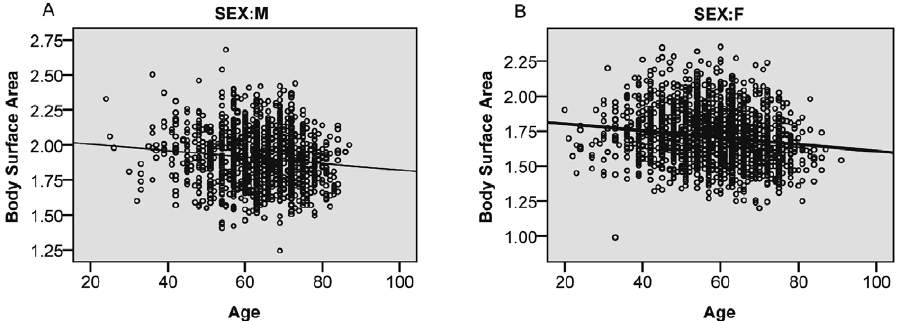
Figure 3. Correlation between age and BSA. The BSA was negatively correlated with age in both genders as shown in the scatterplots above. The Pearson correlation coefficient was 2 0.124 and 2 0.157 respectively and both results were statistically significant (p , 0.0005).